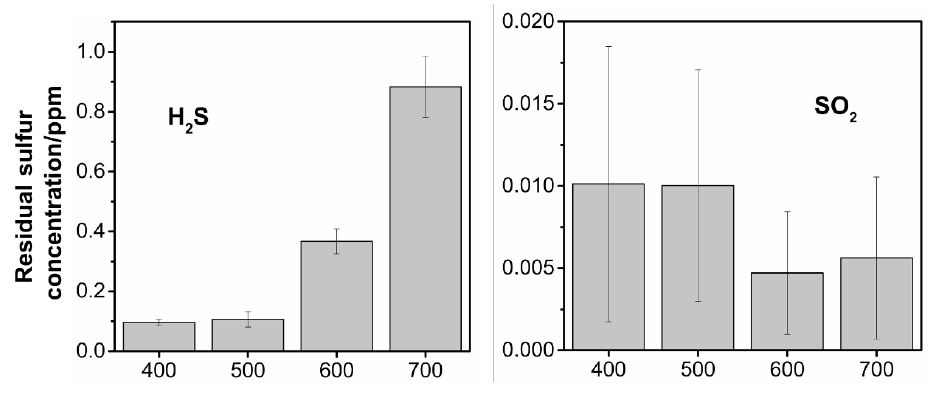
Figure 2. Residual sulfur concentrations measured at various temperatures with sorbent 15Mn8Mo with the gas compositions 0.2, 19.8, 40.0, and 40 vol.% for H 2 S, Ar, H 2 , and N 2 (2000 ppm H 2 S) and 60,000 mL gas /g sorbent h space velocity.